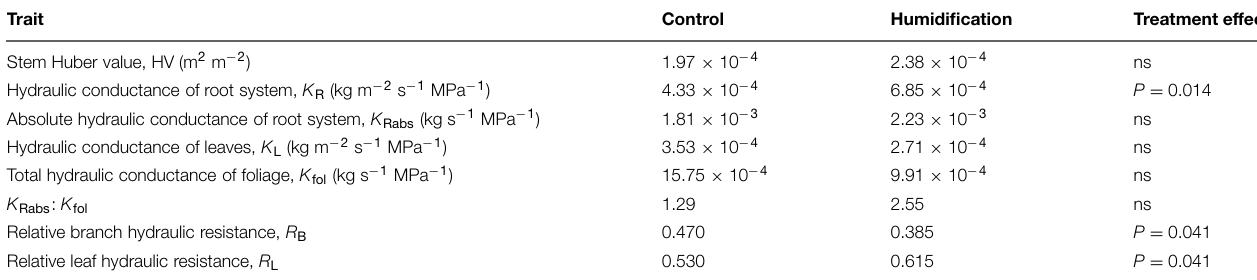
TABLE 6 | Mean values of plant hydraulic traits in control and humidification treatments and treatment effect estimated with analysis of variance. Trait Control